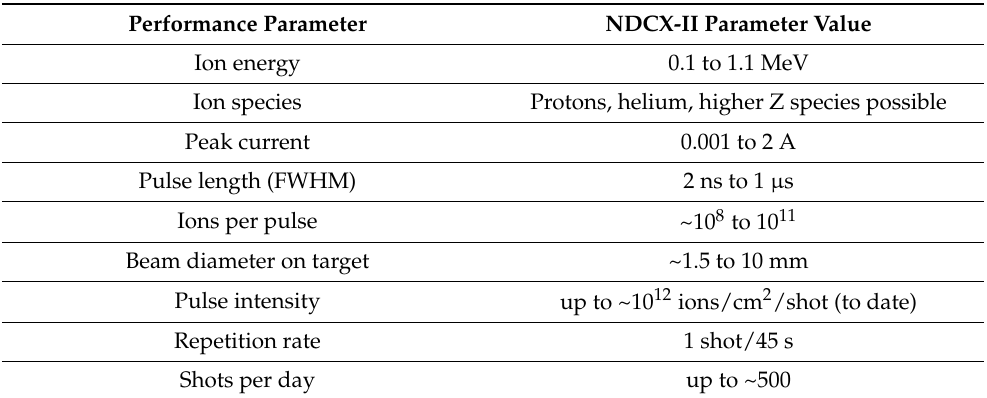
Table 1. List of NDCX-II